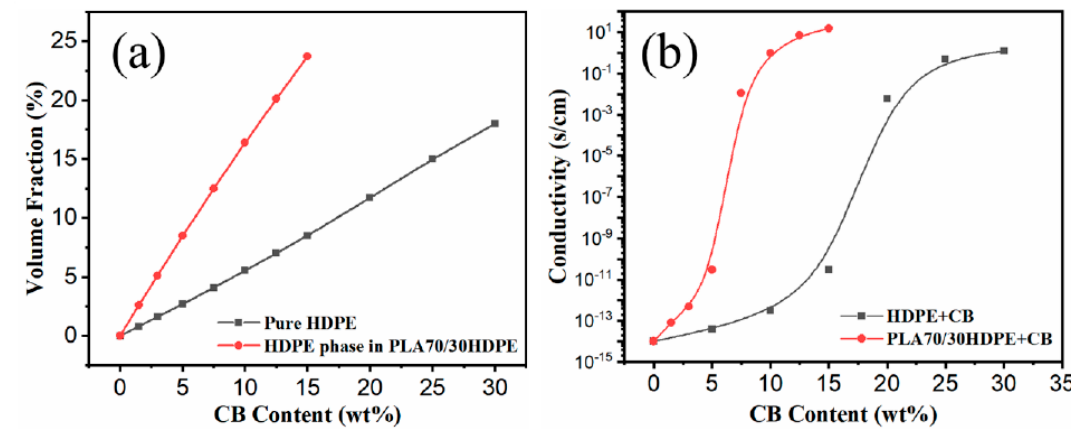
Figure 4. ( a ) The volume fraction of CB in the HDPE phase of PLA70 / 30HDPE blends and HDPE, ( b ) electrical conductivity of PLA70 / 30HDPE / CB blends and HDPE / CB blends.